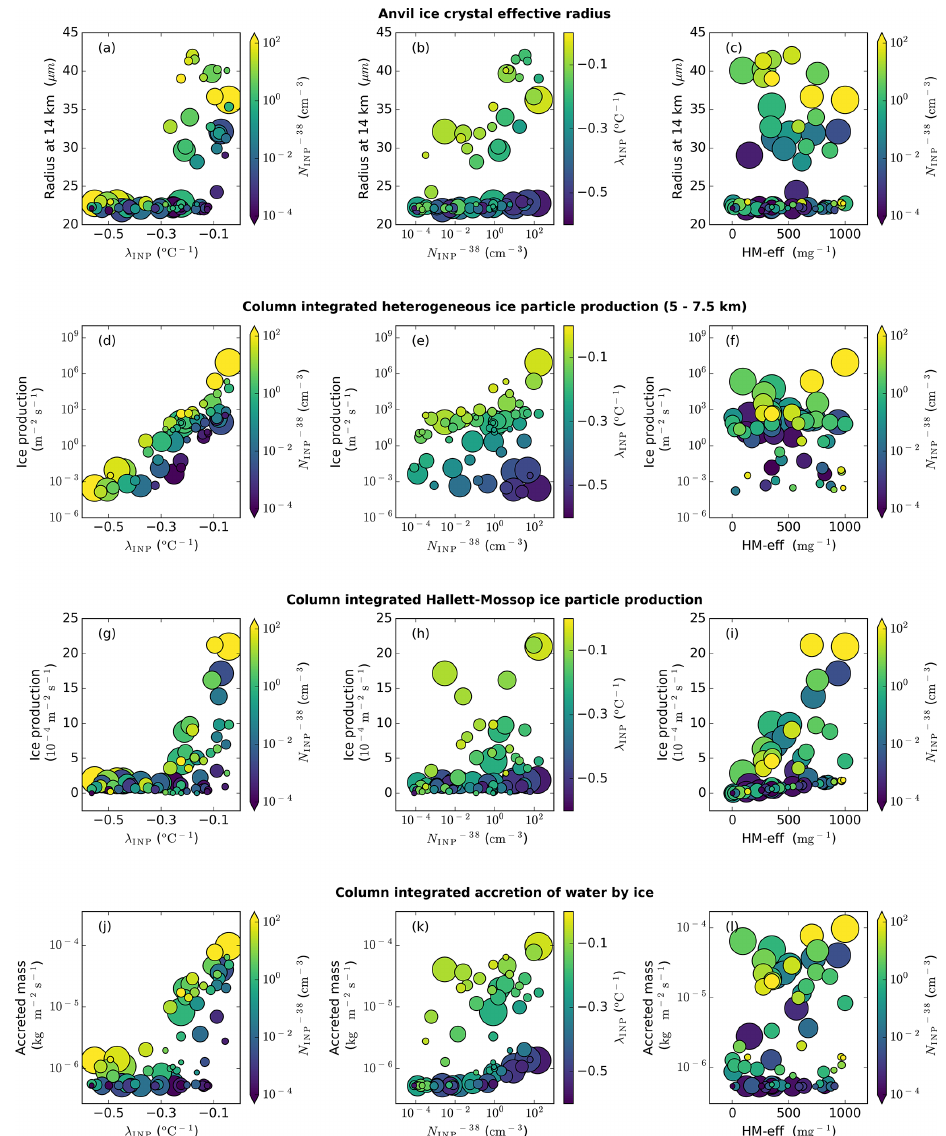
Figure 9. Anvil ice crystal size and driving processes. Dependence of anvil ice crystal effective radius (a–c) , ice particle production by heterogeneous freezing between 5 and 7.5km altitude (d–f) , ice particle production by the Hallett–Mossop process (g–i) , and the accretion of water by ice crystals (j–l) on the three uncertain input parameters: λ INP (a, d, g, j) , N INP − 38 (b, e, h, k) , and HM-eff (c, f, i, l) . For the leftmost column, the colour of the markers indicates N INP − 38 and the marker size indicates HM-eff. For the middle column, the colour of the markers indicates λ INP and the marker size indicates the HM-eff. For the rightmost column, the colour of the markers indicates N INP − 38 and the marker size indicates λ INP . Panels (a) – (c) are the average of the cloud property between 150 and 240min (anvil stage) in the simulation, while panels (d) – (l) are the average of the relevant cloud property between 60 and 180min (convective stage) in the simulations. Note that panels (d) – (f) differ from Fig. 6e–g because of the different altitudes: Figure 6 shows the total column-integrated heterogeneous ice particle production, while Fig. 9 (here) shows only the heterogeneous ice particle production occurring in the Hallett–Mossop region